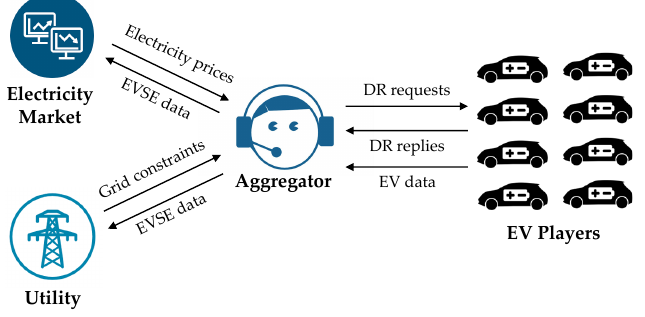
Figure 4. Schematic representation of the price-based control scheme in V2G Demand-Side Management (DSM) applications. EV: Electric Vehicle, EVSE: EV Supply Equipment.